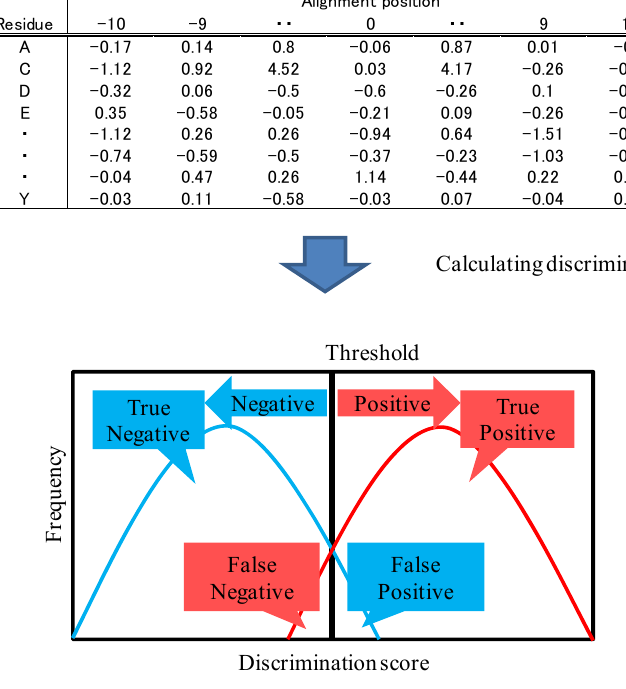
Fig. 1. Flowchart for calculation of position-specific amino acid propensities and PSSM, and discrimination using